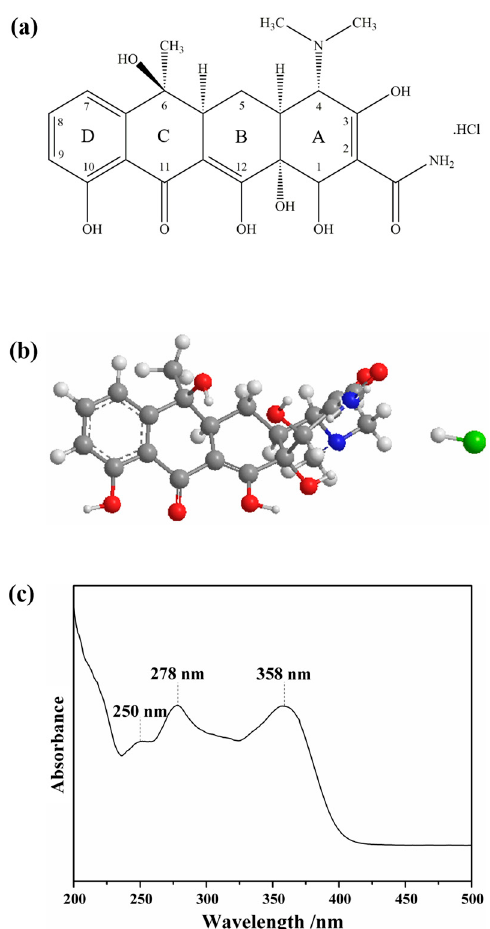
Figure 4. ( a ) Structural formula and ( b ) ball-and-stick representation of a TC molecule; and ( c ) visible spectrum of an aqueous solution of TC.